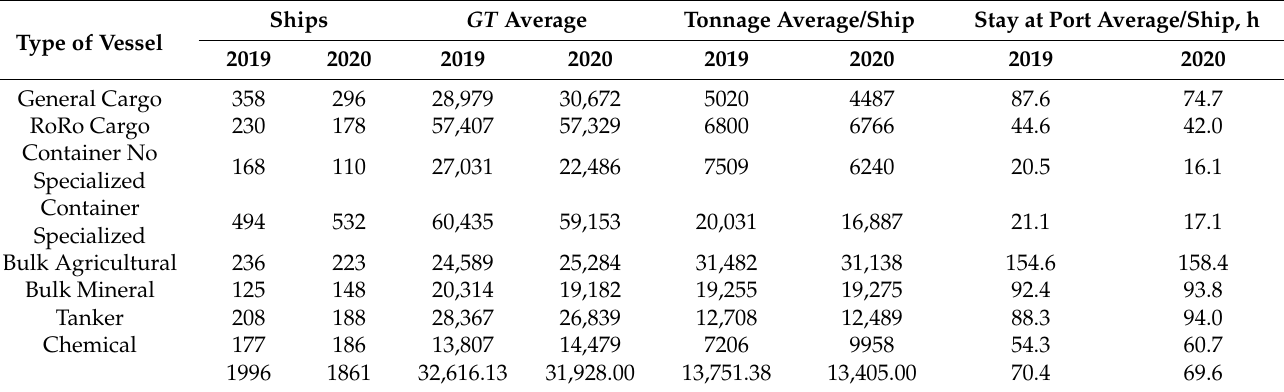
Table 1. Typology of ships in the port of Veracruz [53].